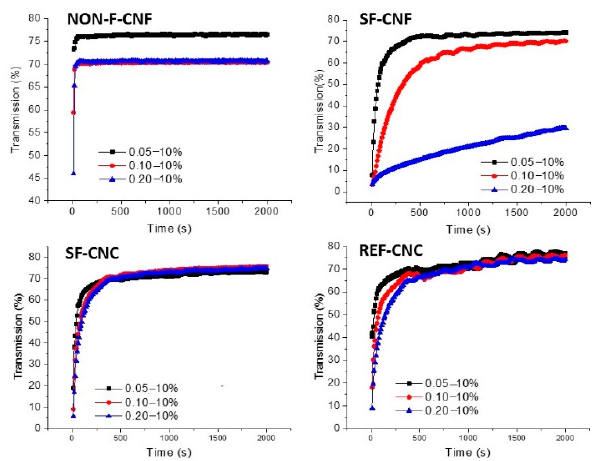
Figure 9. The stability of o / w emulsions against creaming as a function of centrifugation (205 G) time. Nanoparticle samples (NON-F-CNF, SF-CNF, SF-CNC and REF-CNC) at concentrations of 0.05 wt.-%, 0.1 wt.-%, and 0.2 wt.-% with a constant oil dosage of 10 wt.-% were used to stabilize the oil droplets.